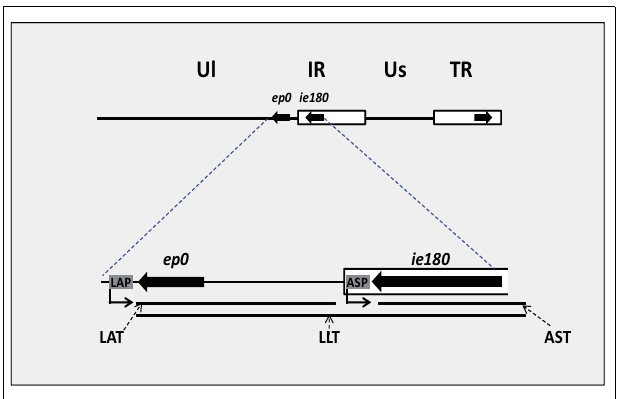
FIGURE 4 |Antisense transcripts regulating the two key transcriptional activators of pseudorabies virus. The immediate early 180 (IE180) and early protein 0 (EP0) proteins are the major regulators of global gene expression of PRV.The latency-associated transcript (LAT), the antisense transcript (AST) and the long latency transcripts (LLT) are RNA molecules transcribed from the complementary DNA strands of these genes from their own promoters.The antisense transcripts are driven by LAP (latency-associated transcript promoter) and ASP (antisense